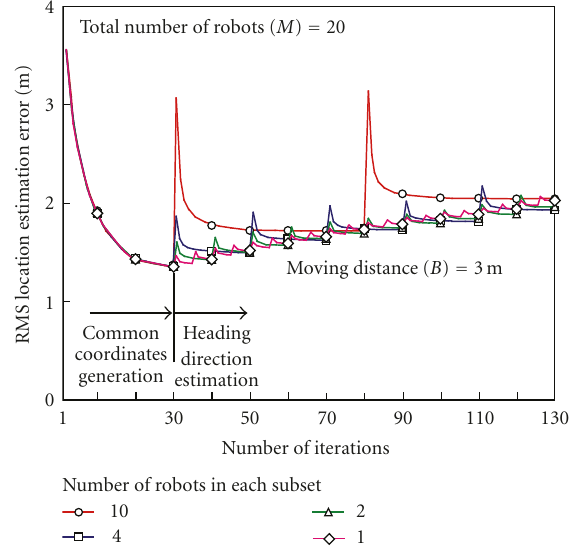
Figure 9: E ff ect of the number of location/direction estimation steps on the location estimation error in the heading direction estimation.